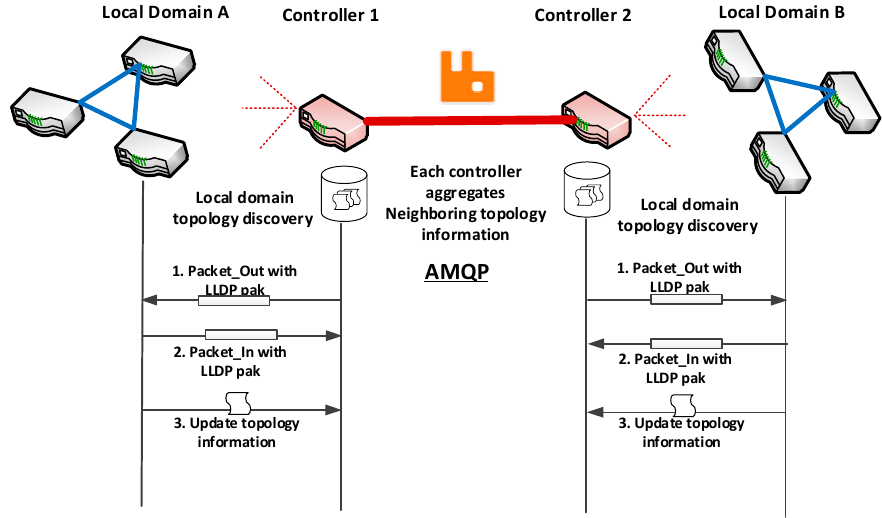
Figure 5. Messages flow for the aggregated topology discovery mechanism.